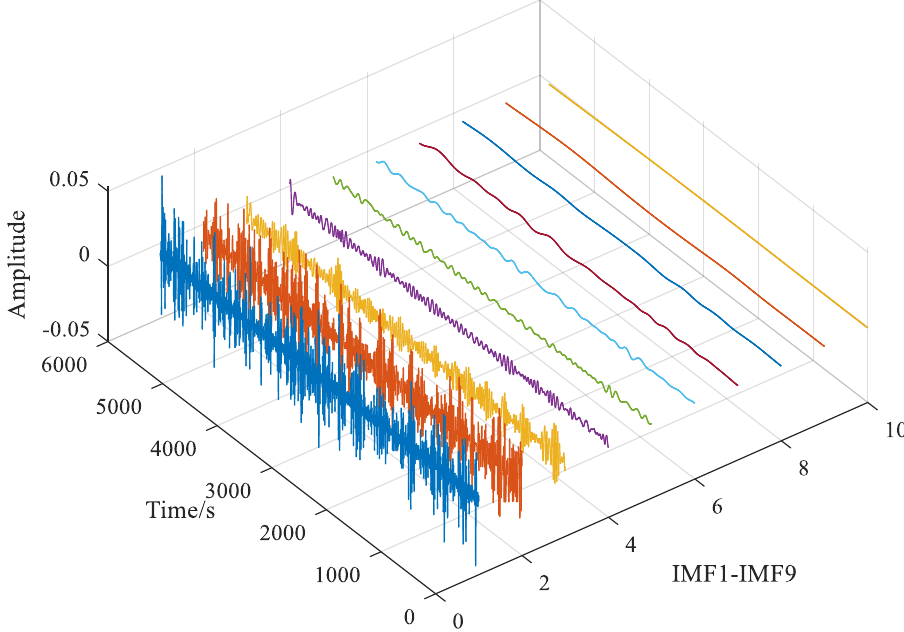
Figure 5. ACE signal decomposition curve based on EMD.